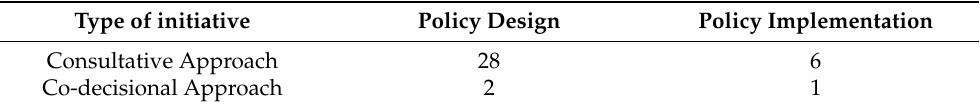
Table 3. Number of senior citizens’ participatory initiatives in policy-making, by type of initiative.